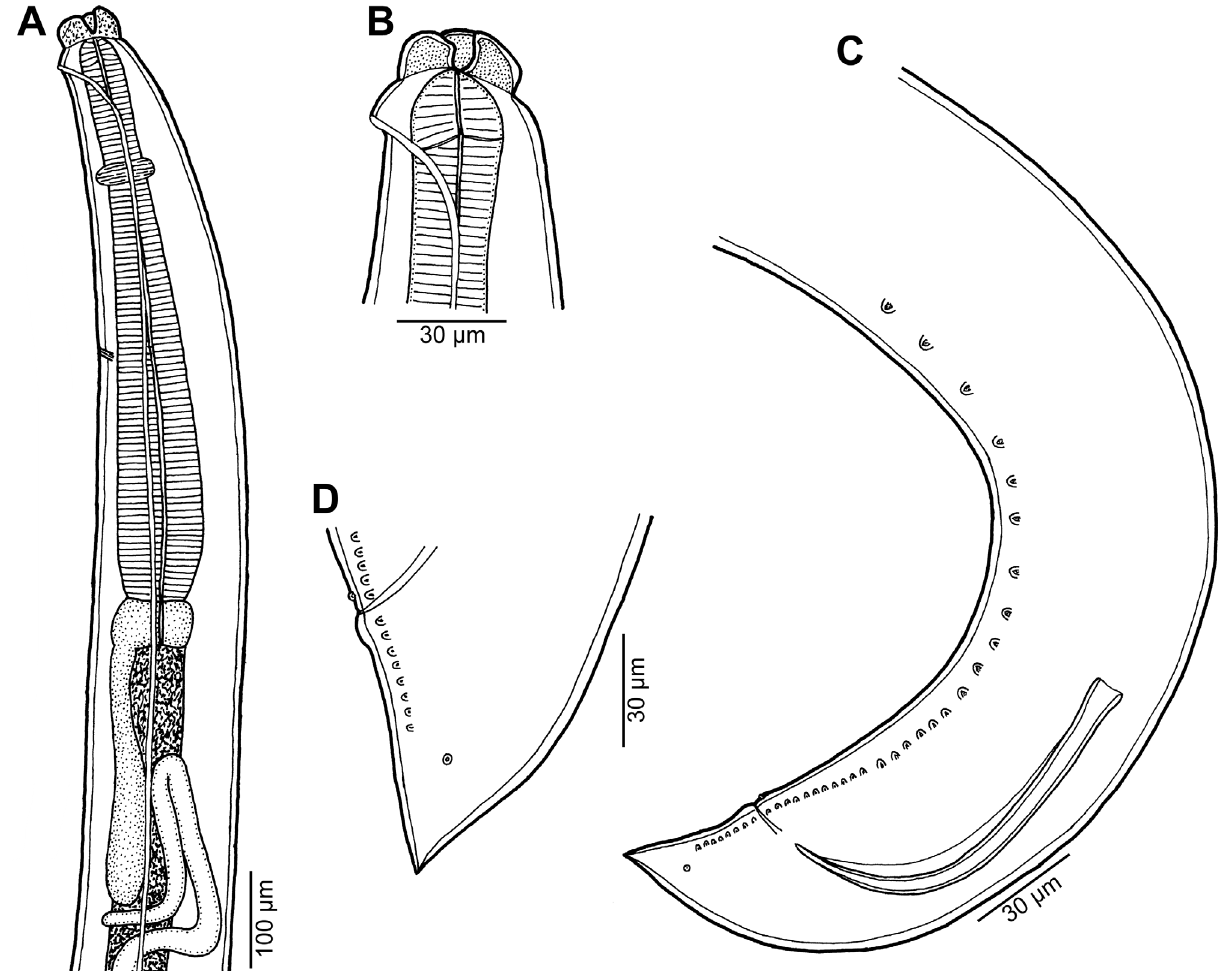
Figure 6. Raphidascaris ( Ichthyascaris ) nudicauda n. sp. ex Saurida undosquamis , male. (A) Anterior end of body, lateral view; (B) cephalic end, lateral view; (C) posterior end of body, lateral view; (D) tail, lateral